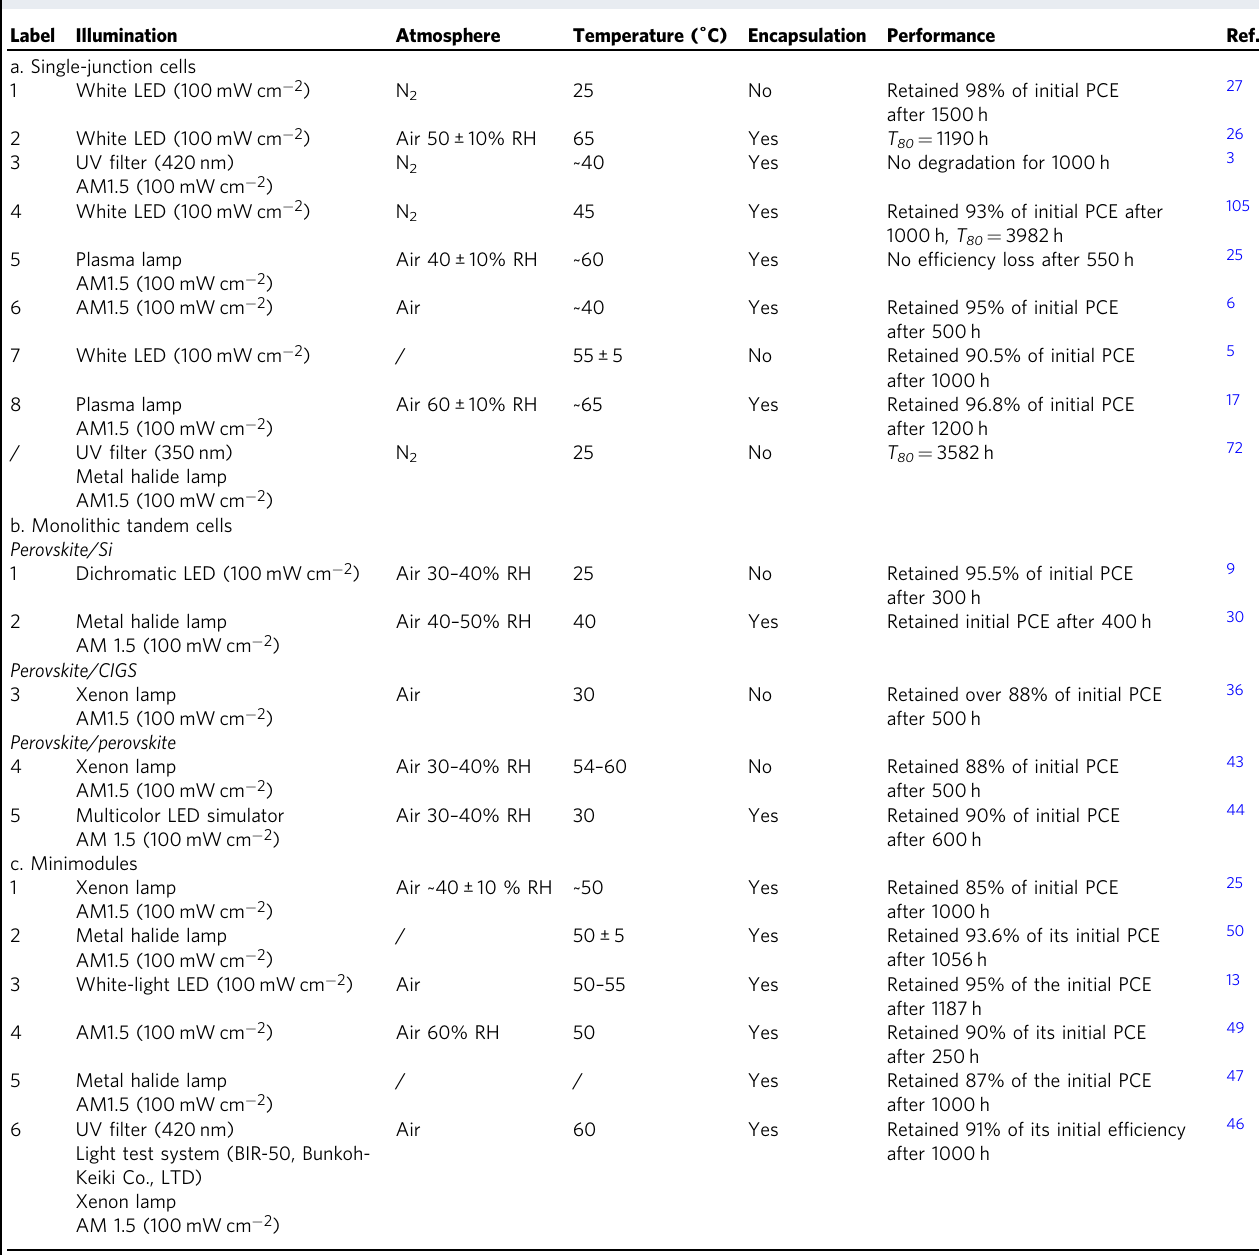
Table 3 Comparisons of MPPT in high-performance IPSCs based on rigid